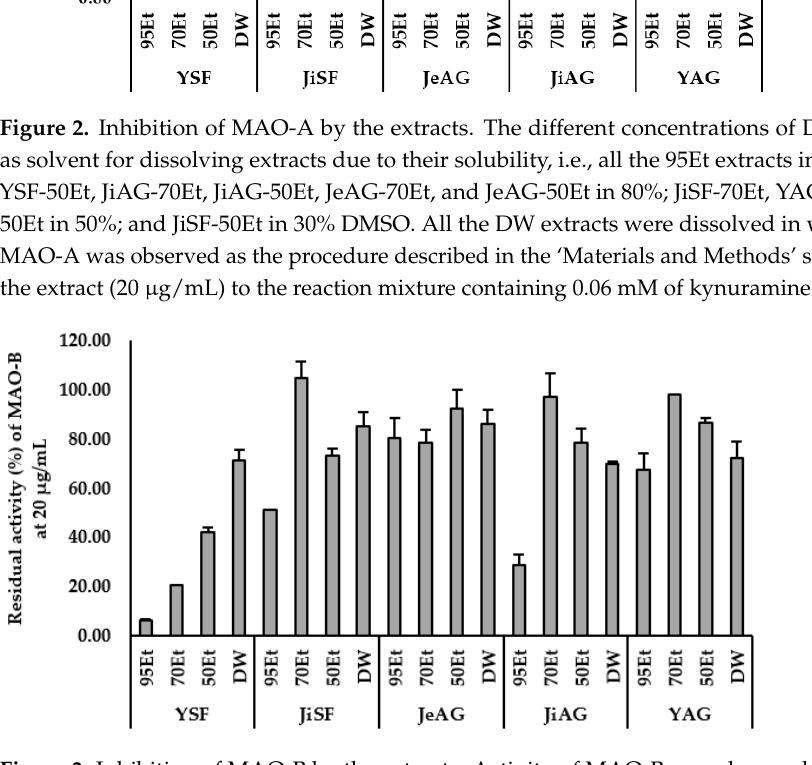
Figure 3. Inhibition of MAO-B by the extracts. Activity of MAO-B was observed as the procedure described in the ‘Materials and Methods’ section, by adding the extract ( 20 μg/mL ) to the reaction mixture containing 0.30 mM of benzylamine.